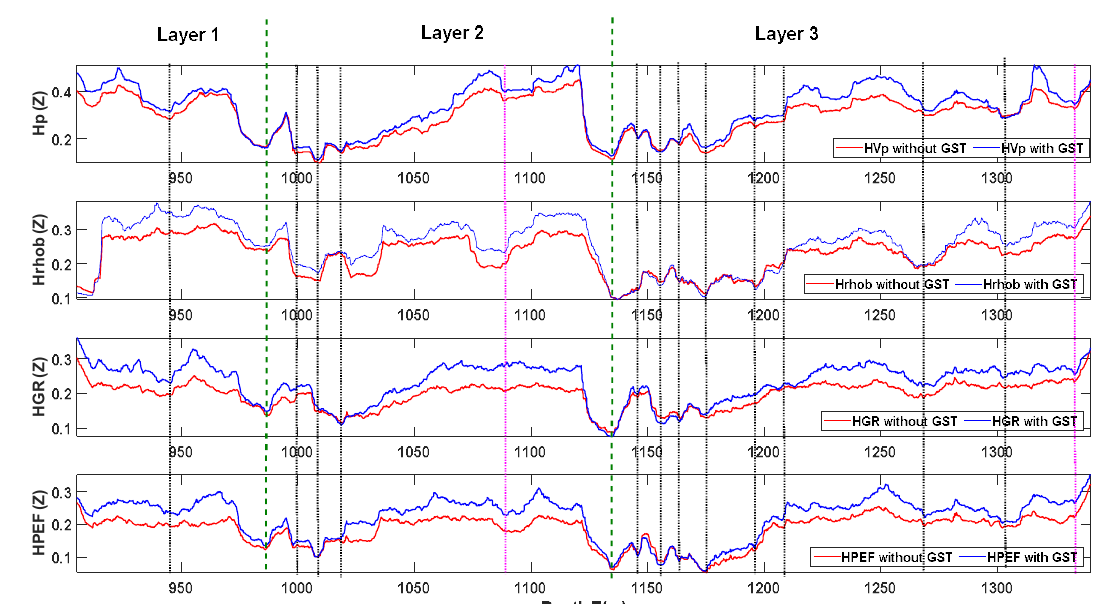
Figure 5. Physical properties measured within the depth interval (905–1340 m) in borehole W1: the raw data (in red) and the data processed by the GST (in blue) [35].